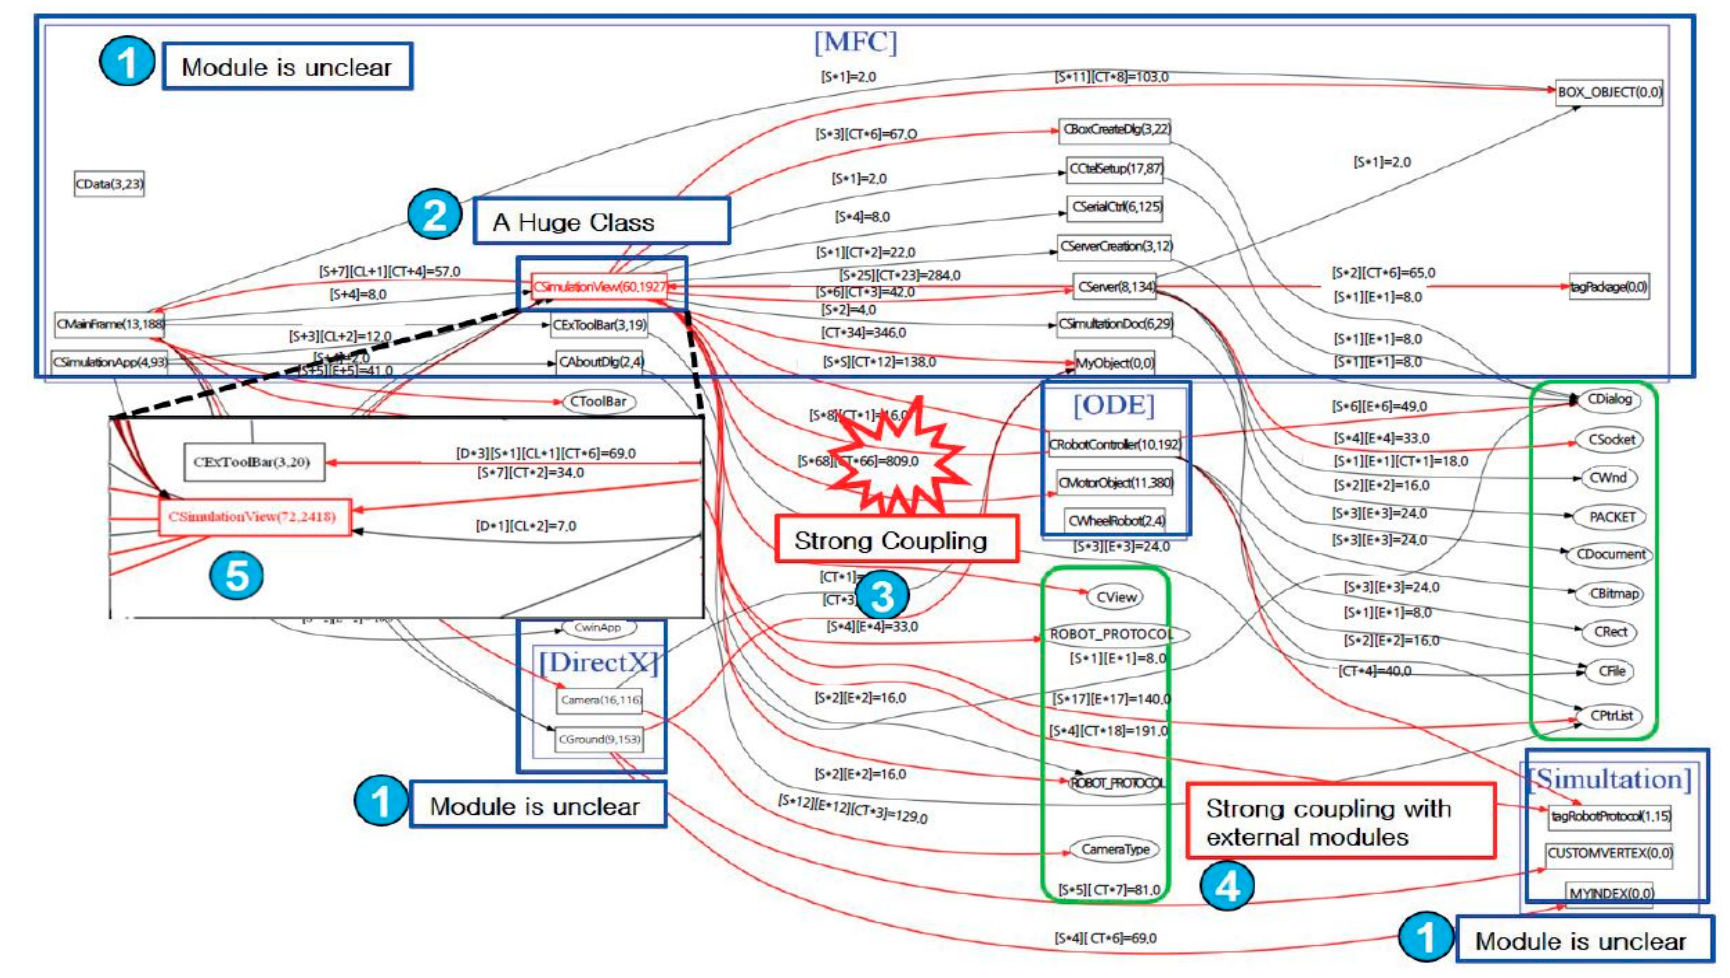
Figure 4. The inner code architecture of the multiple-joint robot simulator before refactoring.